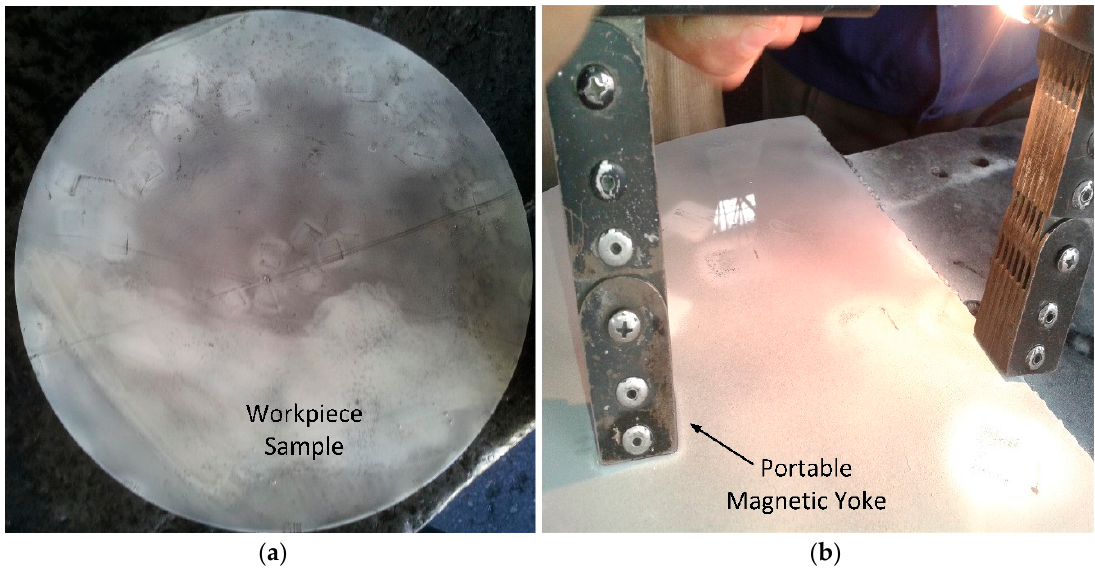
Figure 6. ( a ) Prepared sample for magnetic particle testing (MT); ( b ) MT yoke system to detect cracks.